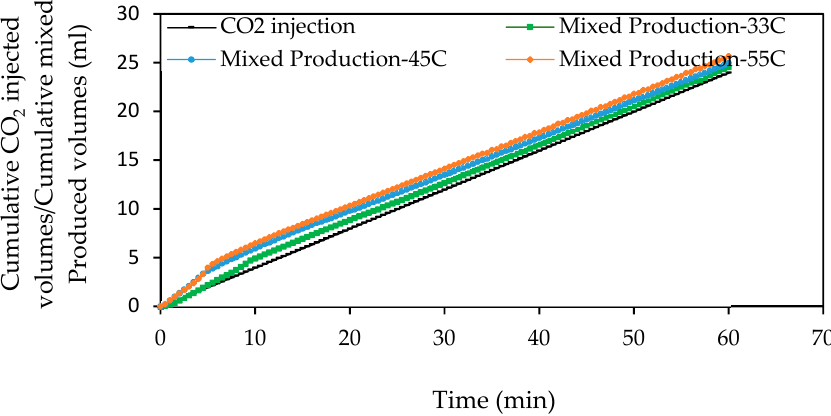
Figure 21. Effect of experimental temperature on the cumulative produced volumes of oil and CO 2 for low-pressure GCO 2 –oil displacements conducted at 40 bar and 0.4 mL/min.